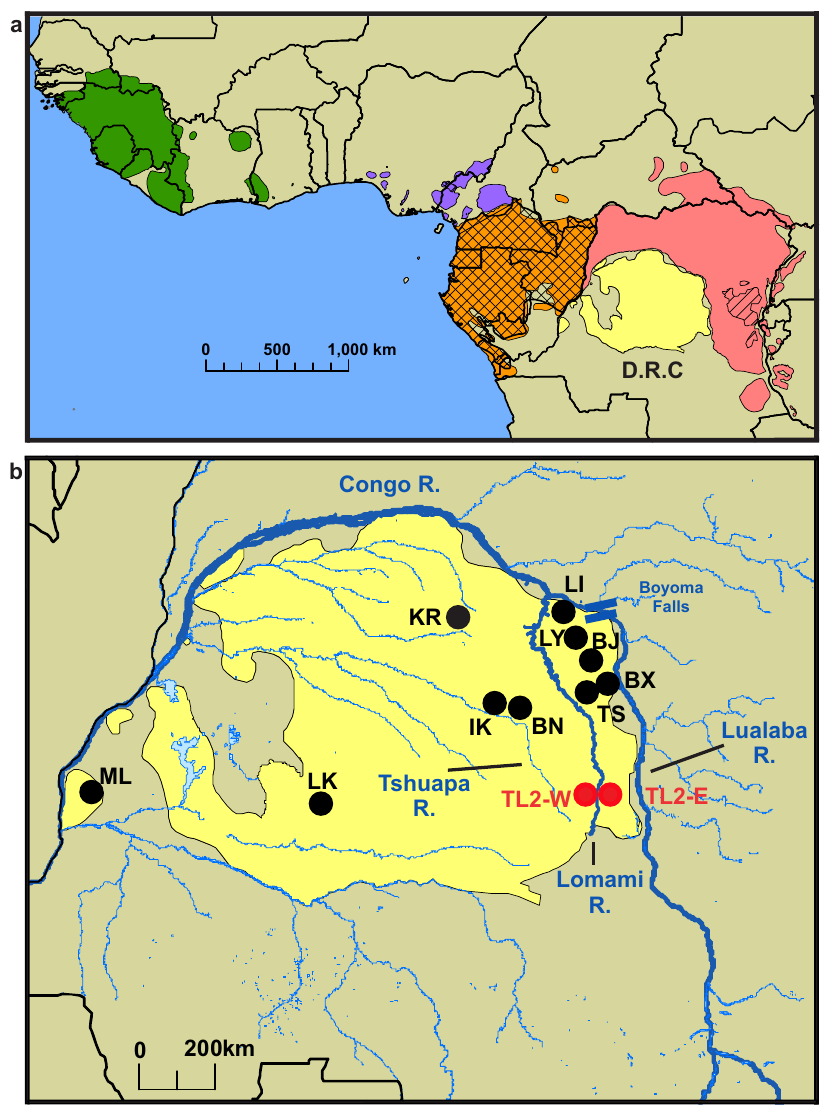
Fig.1|Africanaperanges,bonobostudysites,andpresenceof Laverania .a The ranges of bonobos ( Pan paniscus , yellow), western chimpanzees ( Pan troglodytes verus , green), Nigeria-Cameroonian chimpanzees ( P. t. ellioti , purple), central chimpanzees ( P. t. troglodytes , orange), eastern chimpanzees ( P. t. schweinfurthii , red), western gorillas ( Gorilla gorilla , cross hatch), and eastern gorillas ( Gorilla beringei , single hatch) are shown. Laverania parasites have been detected in all African ape species, except the Easterngorilla. Range data were obtainedfrom the